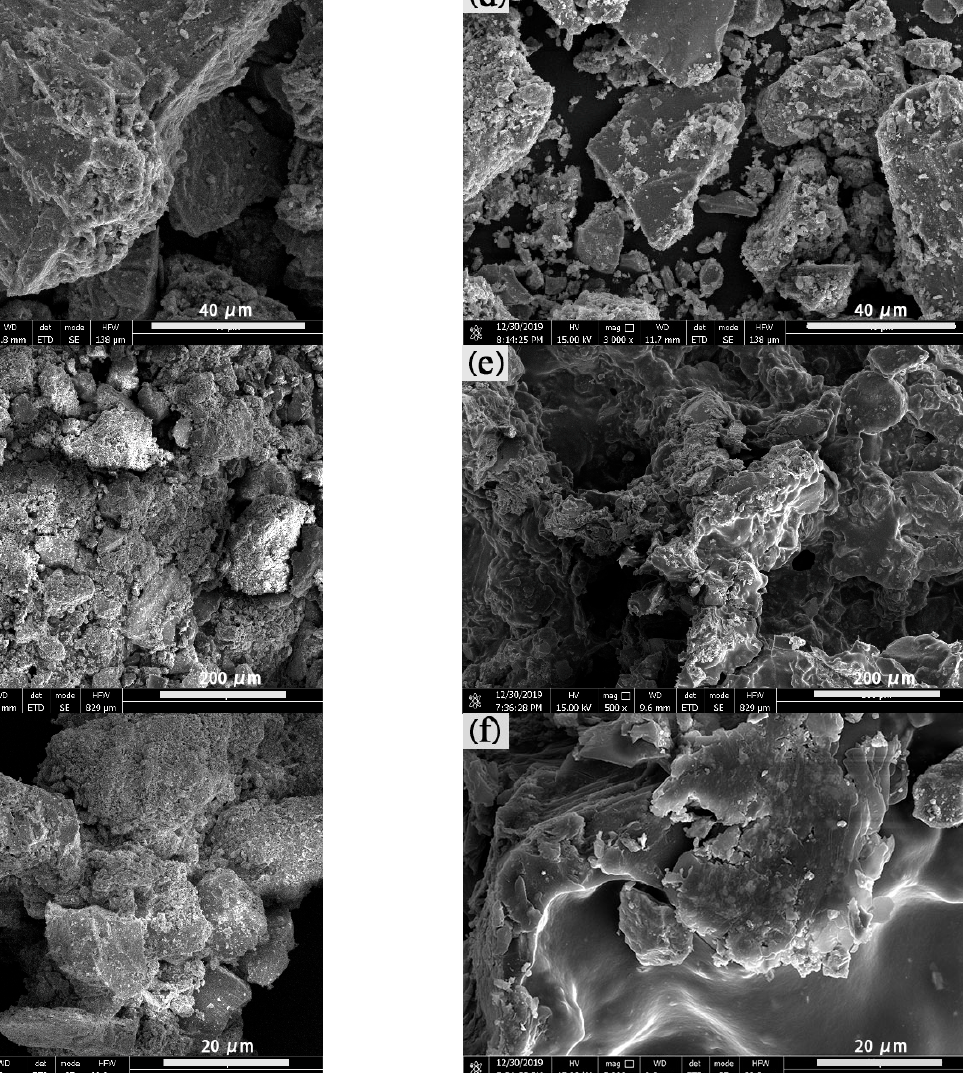
Figure 16. SEM images of ( a ) iron ore particles of sample A; ( b and c ) the mixture of sample A, binder and water; ( d ) iron ore particles of sample B; ( e and f ) the mixture of sample B, binder and water.